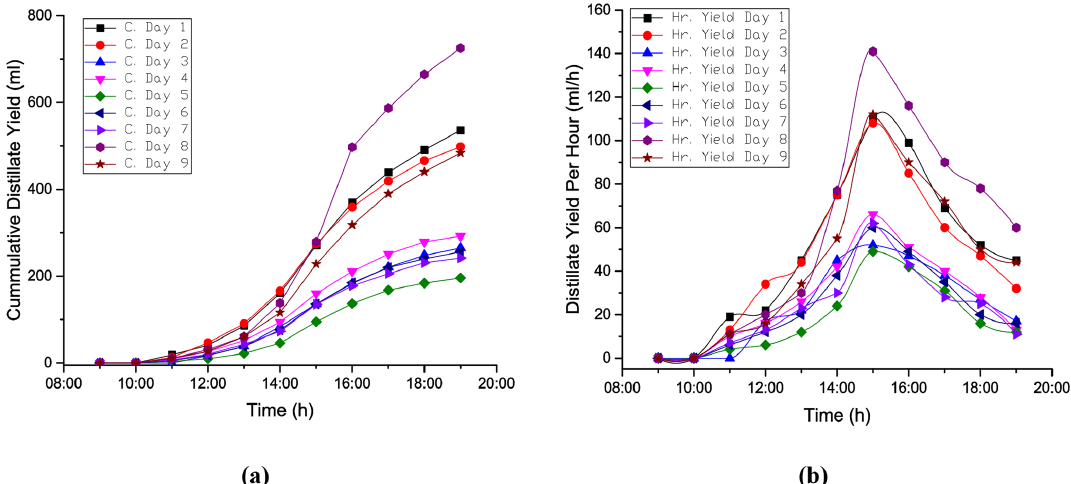
Figure 6. Distillate yield. (a) Cumulative distillate yield. (b) Distillate yield per hour.